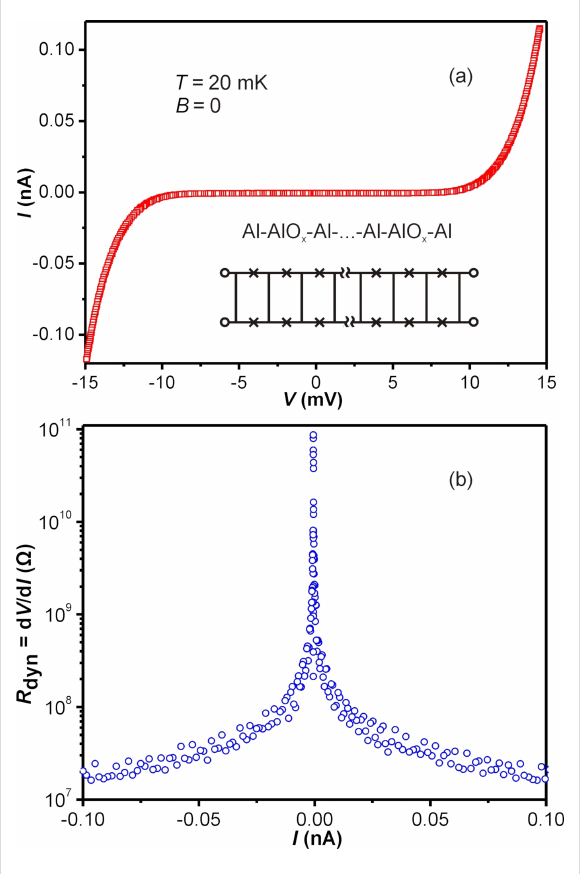
Figure 2: (a) Experimental I – V characteristics of 50 pairs of Al–AlO x junctions connected in series. Inset shows a schematic of the struc- ture. (b) Dynamic resistance R dyn ≡ d V /d I obtained by numeric differ- entiation of the I – V